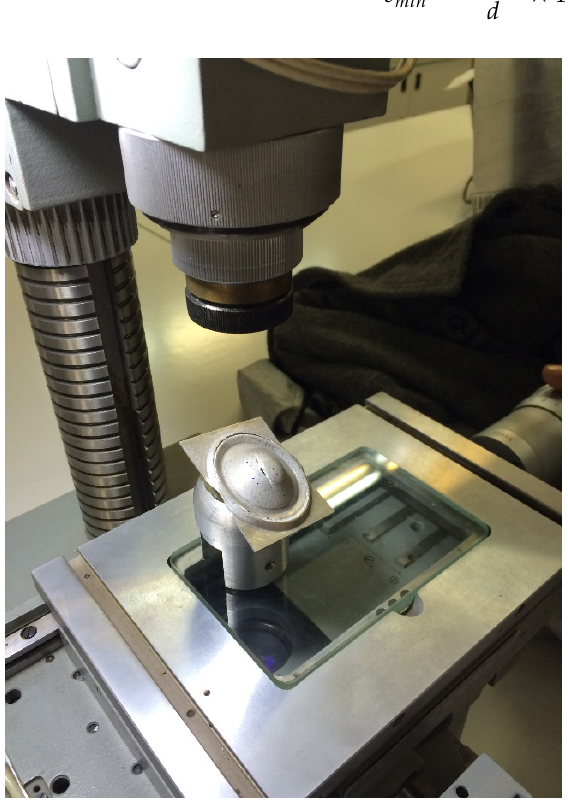
Figure 2. A sheet sample after necking